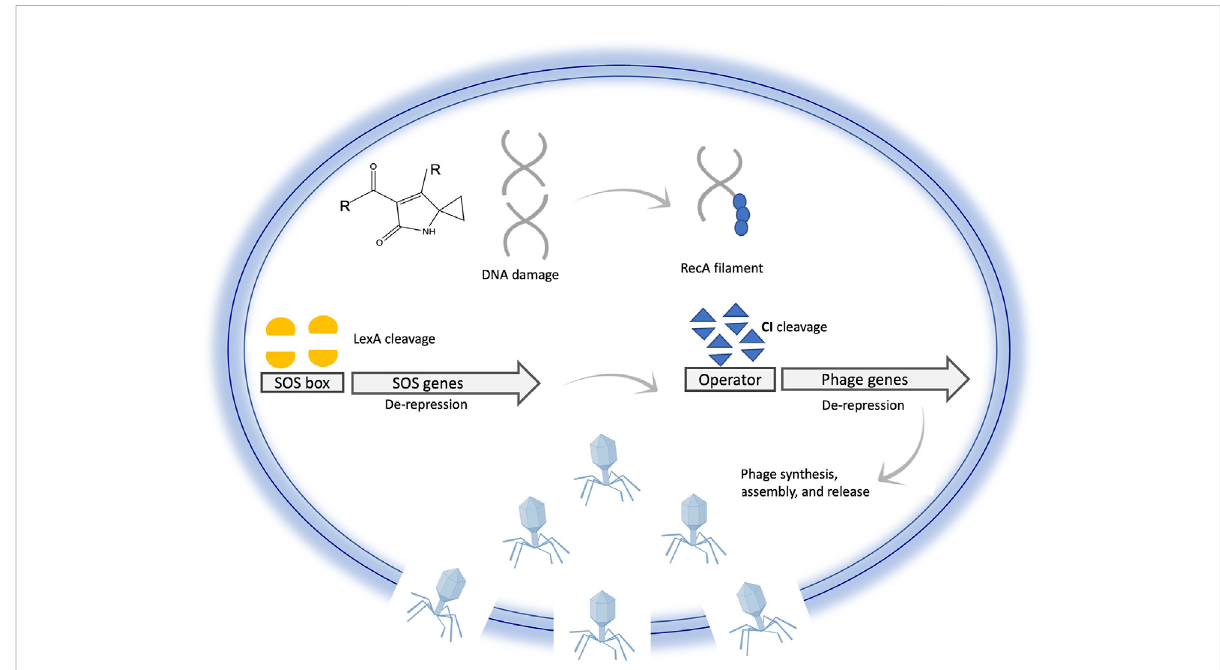
FIGURE 6 Illustration of prophage activation following DNA damage inside a bacterial cell. DNA damage induces cleavage of phage repressor genes mediated by SOS signaling. Cleavage of the phage repressor leads to exciton of prophage from the bacterial chromosome, synthesis of phage- related genes and proteins, assembly, cell lysis, and phage release. This illustration is simpli fi ed to communicate the main idea; for example CI binds to two distant regions and not only to one site as shown for simplicity of the